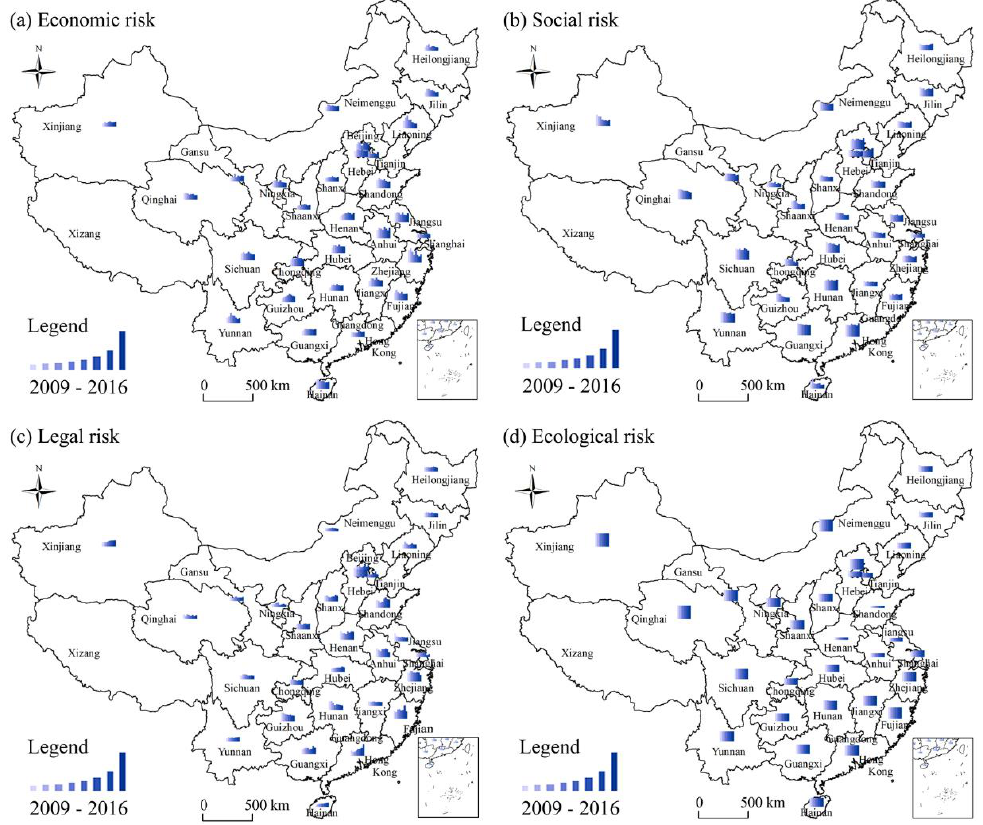
Figure 9. The spatial and temporal evolution of four types of risks.